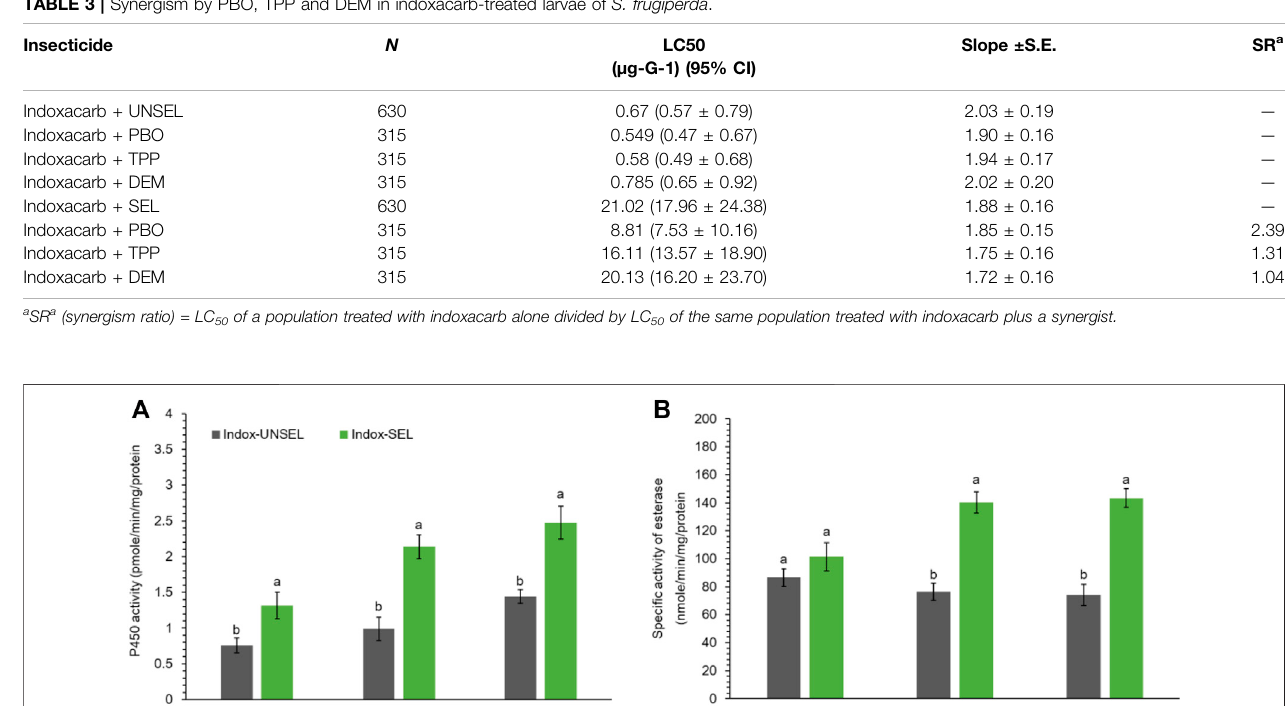
Frontiers in Physiology |